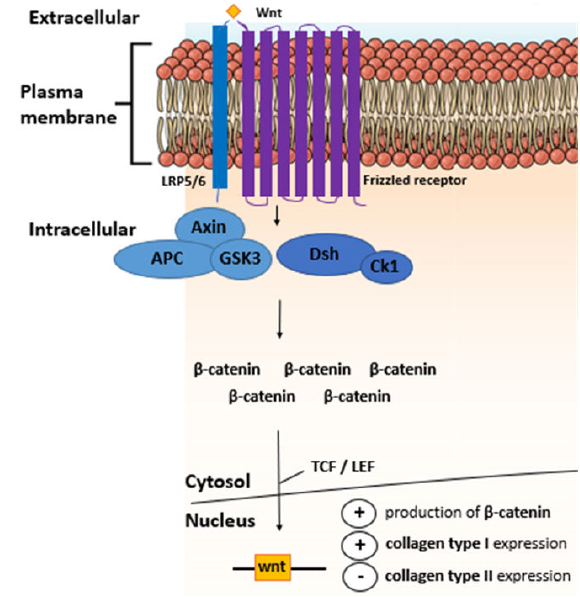
Figure 4. Material sti ff ness-induced Wnt signaling. Binding of a Wnt ligand to the Frizzled receptor and LRP5 / 6 receptor activates the Wnt signaling pathway. Wnt causes translocation of Axin and the destruction complex adenomatous polyposis coli (APC) and glycogen synthase kinase 3 (GSK3) to the plasma membrane, inhibiting β -catenin degradation through the destruction complex. Dsh becomes activated and β -catenin accumulates in the cytoplasm. β -catenin translocates into the nucleus and promotes target gene expression of Wnt genes through binding TCF / LEF co-activators and further production of β -catenin. Increasing β -catenin leads to higher expression of type I collagen and decreased expression of type II collagen in